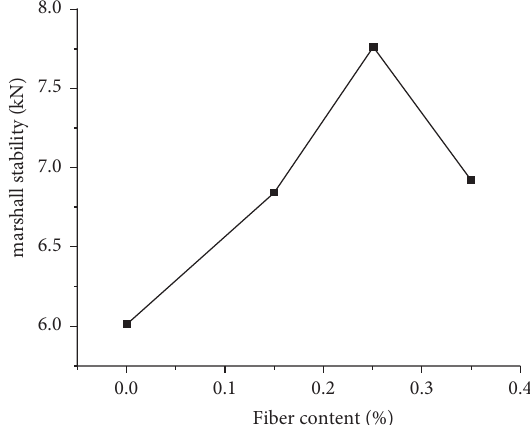
Figure 6: Basalt fiber content-Marshall stability relationship diagram.